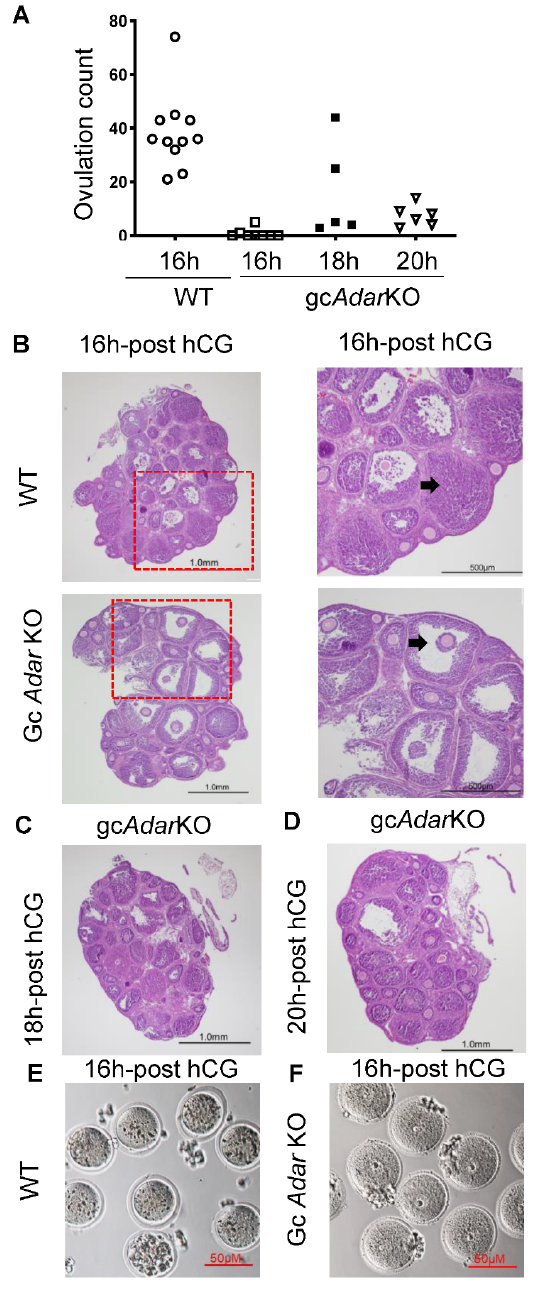
Figure 3. Granulosa specific Adar knockout leads to delayed and altered ovulation. ( A ) Ovulated eggs retrieved from oviducts 16, 18, and 20 h after ovulation induction. Eggs were collected from oviducts of immature, 24-day-old WT and gc Adar KO after 46 h of eCG stimulation followed by 16, 18 and 20 h of hCG treatment. A delay and reduction in the number of eggs ovulated was observed in gc Adar KO mice compared to WT controls. ( B ) Histological analyses of ovaries from immature superovulated WT and gc Adar KO mice. Ovaries from WT mice display corpora lutea (CL) and ovulation sites, while gc Adar KO ovaries display trapped oocytes with lack of luteinization of follicles at 16 h post-hCG administration. ( C , D ) Variation in luteinized follicles with trapped oocytes (arrowhead) are observed at 18 and 20 h post-hCG administration. ( E ) Ovulated oocytes from WT mice 16 h post-hCG isolated from ampulla of the oviduct. ( F ) Oocytes from gc Adar KO ovaries, isolated by puncturing antral follicles with 28-gauge